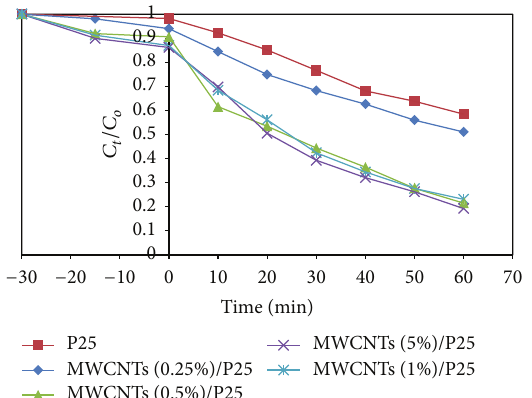
Figure 9: Adsorption and irradiation at different ratios of the MWCNTs/P25 composite.